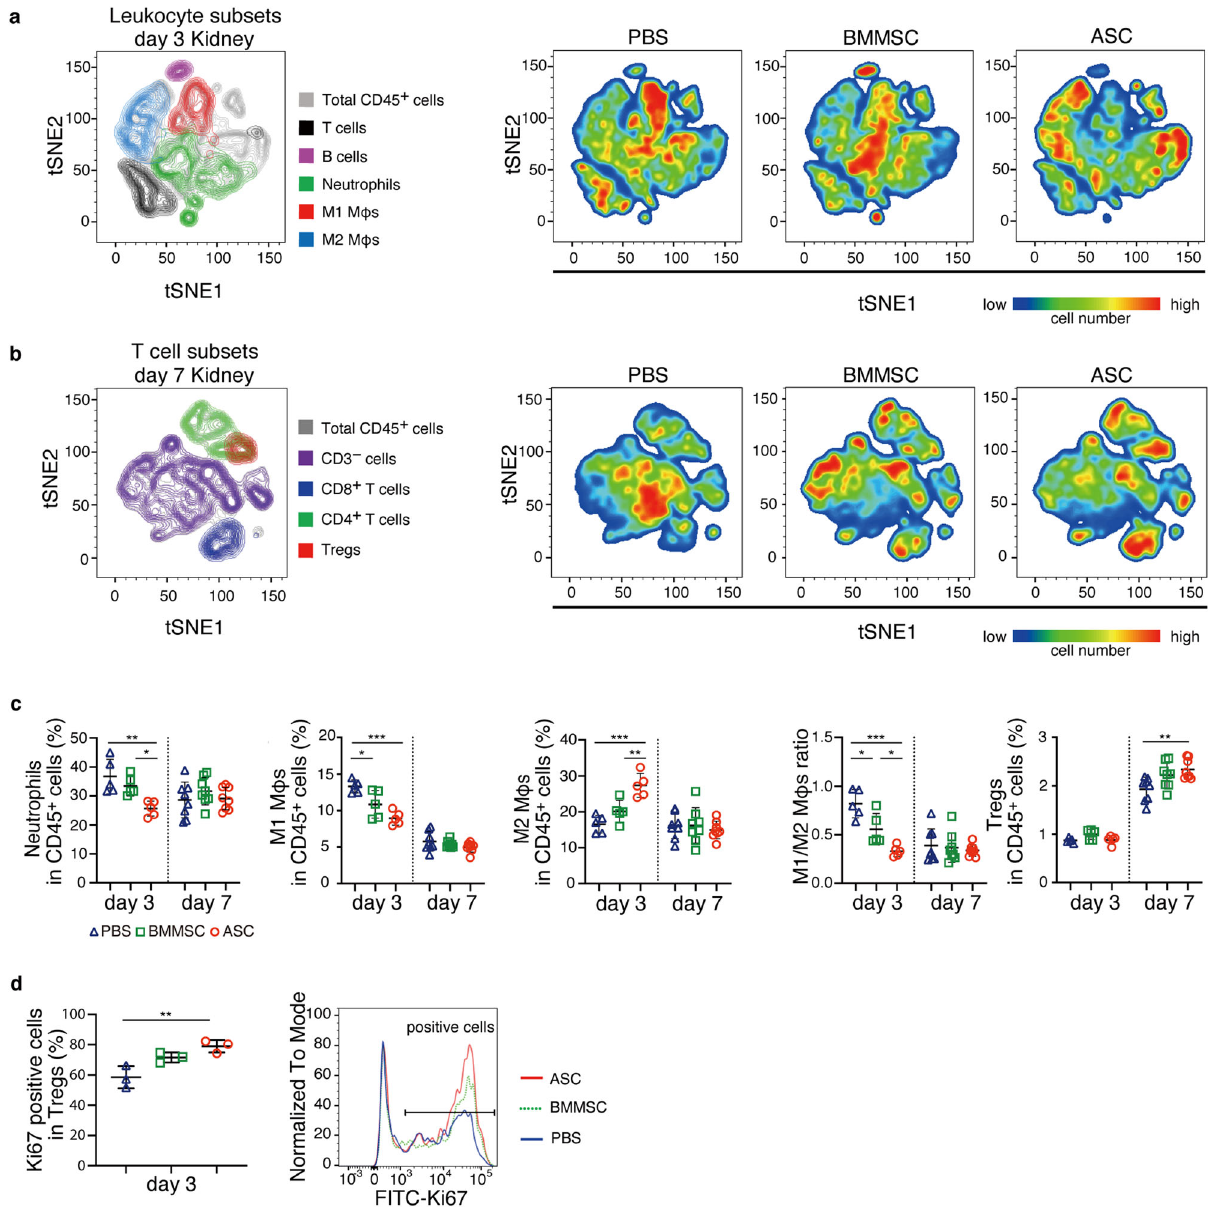
a , b T-distributed stochastic neighbor embedding (tSNE) implementation for fl ow cytometry data visualization of leukocyte subsets and T-cell subsets. The data are presented as color-coded leukocyte population overlays (left) or cell number density color-coded (right) in the tSNE space. a Kidney samples on day 3 were divided into the following cell clusters: CD45 + cells, T cells, B cells, neutrophils, and M1 and M2 macrophages. b Kidney samples on day 7 were divided into the following clusters: CD45 + cells, non-CD3 + cells, CD8 + T cells, CD4 + T cells, and Tregs. c Frequency of renal leukocyte subsets in CD45 + cells analyzed by fl ow cytometry on days 3 and 7 (day 3, n = 5 per group; day 7, n = 8 per group). d The proportion of Ki67-positive cells in the renal Treg subset on day 3 ( n = 3 per group). All data are shown as means ± SD. * p ≤ 0.05, **p ≤ 0.01, *** p ≤ 0.001 as determined by